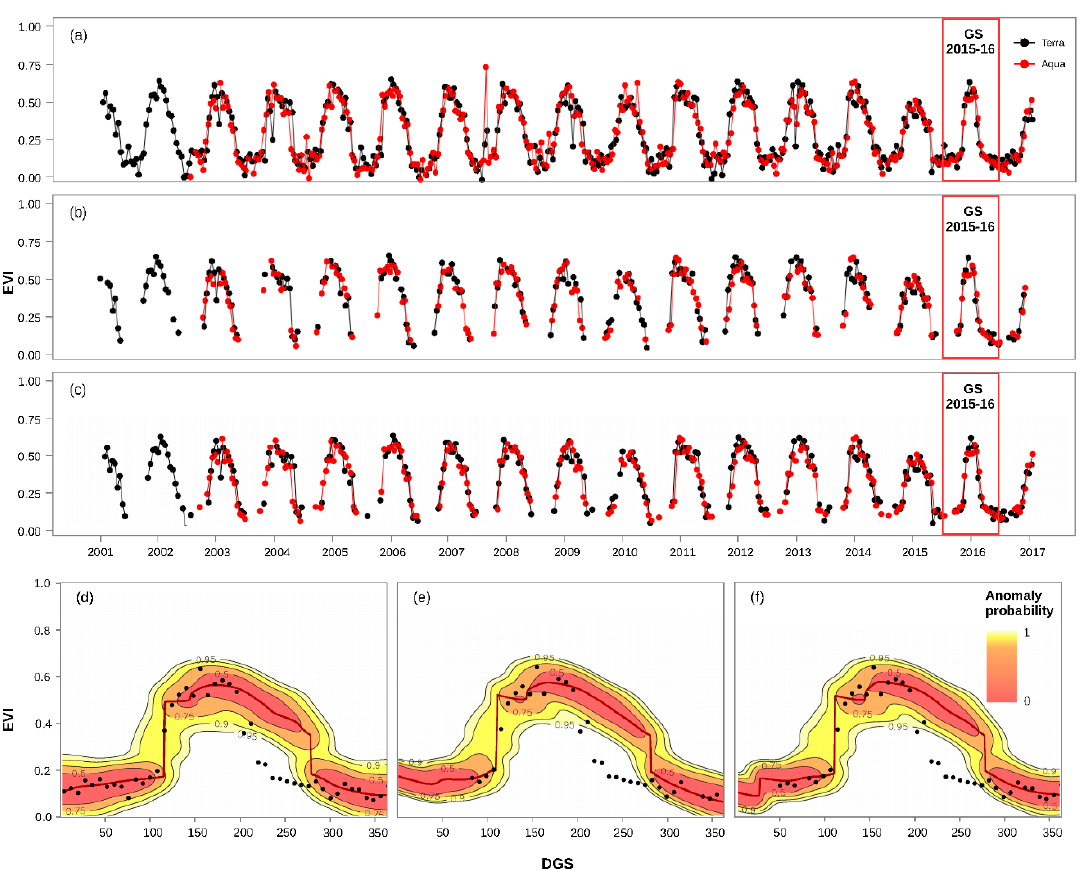
Figure 10. EVI time series ( a – c ) and kernel estimation ( d – f ) using different schemes of MODIS quality assessment (QA) bands: ( a – d ) with no QA applied, ( b – e ) with QA using the pixel reliability band